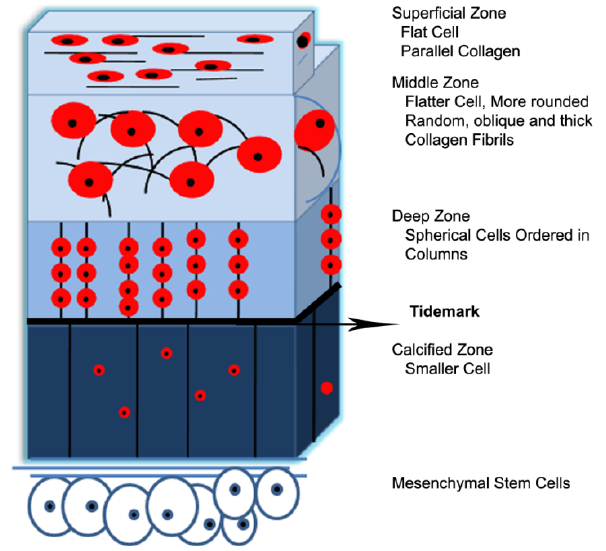
Figure 1. Zonal organization in normal articular cartilage, the black lines and the red solids represent collagen fibrils and chondrocytes,